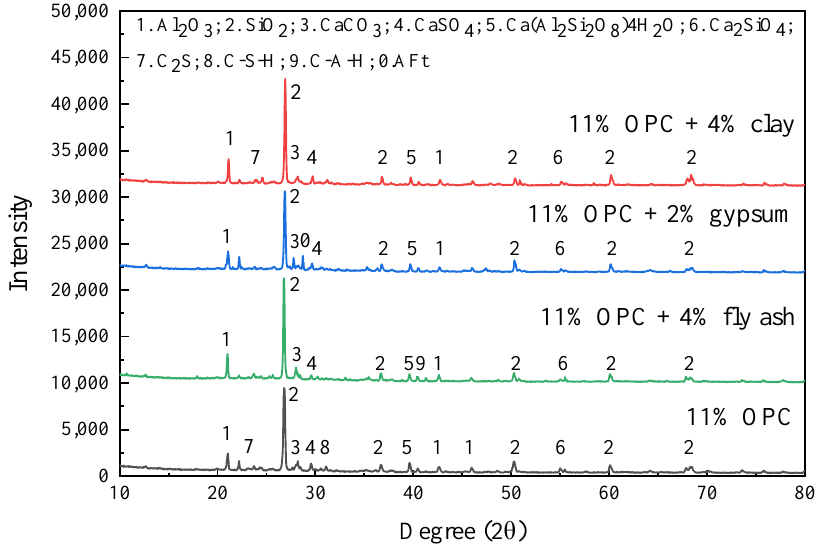
Figure 13. XRD pattern contrast of solidified sandy silty soil at the age of 28 days.